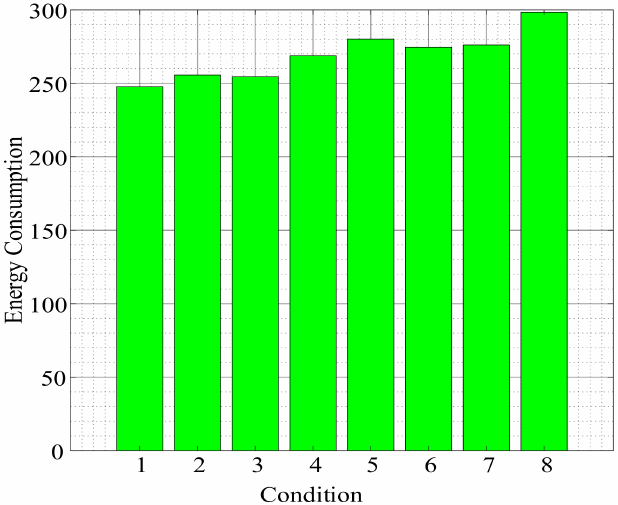
Figure 20. Overall energy depending on relay location in different nodes.